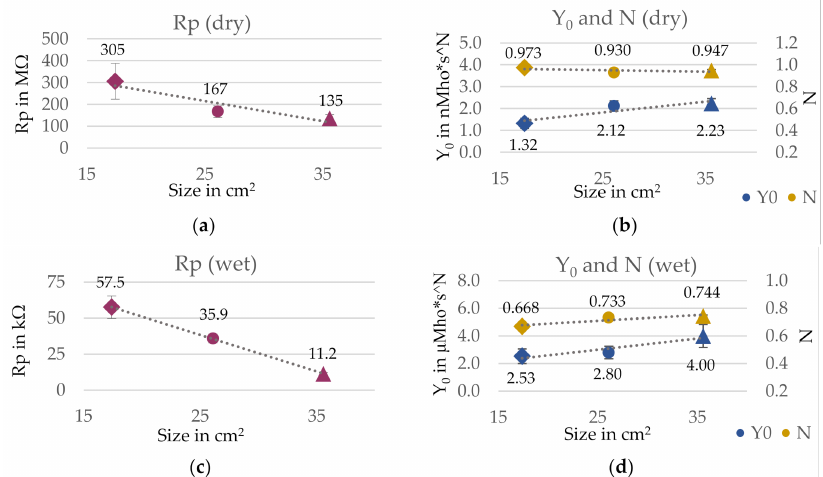
Figure 7. Influence of the electrode size on the equivalent circuit elements for electrode version E1. ( a ) Charge transfer resistance Rp and ( b ) CPE parameters Y 0 and N in dry condition. ( c ) Charge transfer resistance Rp and ( d ) CPE parameters Y0 and N in wet condition. Estimated error indicated with error bars and linear trend lines as dashed lines. Goodness of fit in dry: χ 2 (17.4 cm 2 ) = 16.9; χ 2 (26.1 cm 2 ) = 9.4; χ 2 (35.6 cm 2 ) = 7.6; and in wet: χ 2 (17.4 cm 2 ) = 8.4; χ 2 (26.1 cm 2 ) = 4.8; χ 2 (35.6 cm 2 ) =